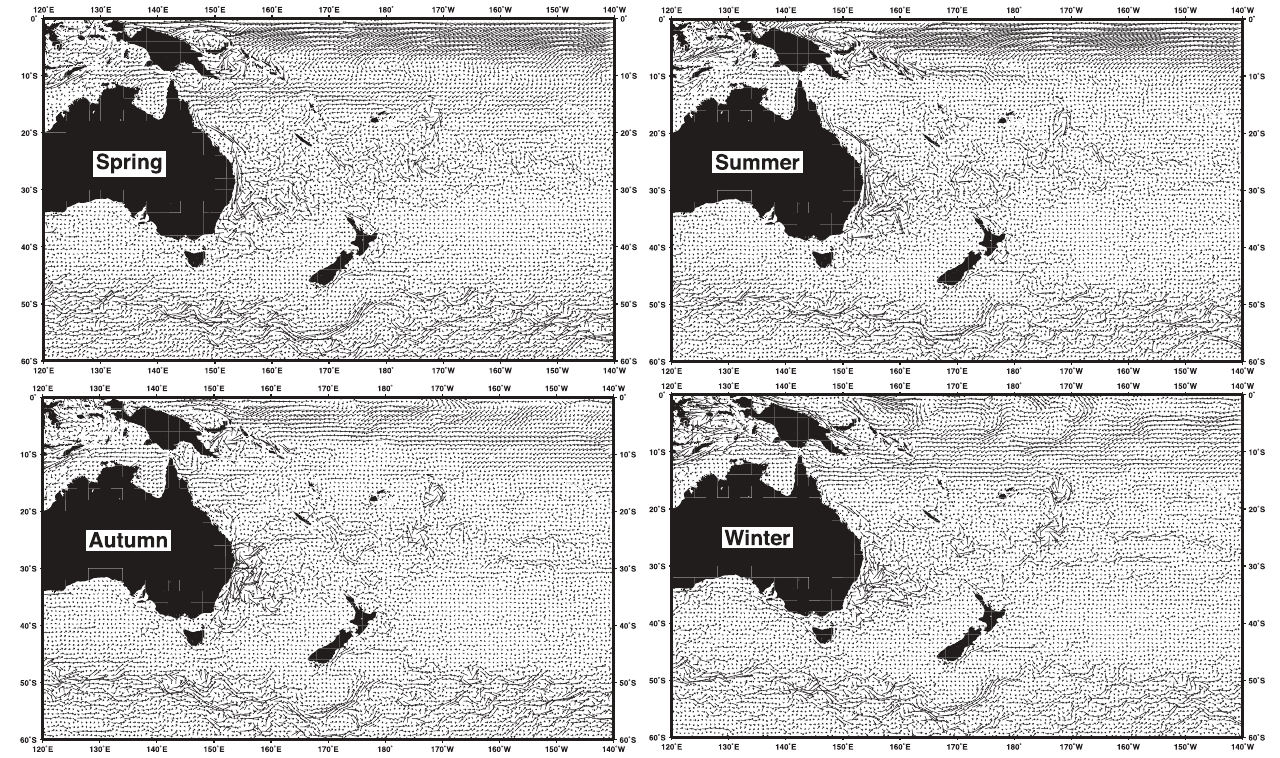
Figure 2. Seasonal HYCOM shallow currents (2008–2009 cycle: Spring=September–November, Summer=December–February, Autumn=March–May, and Winter=June–August.